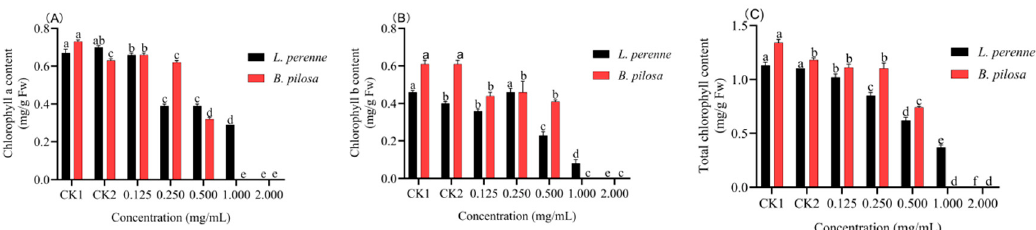
Figure 2. Effect of different concentration of L. pungens essential oil on photosynthetic pigments content (CK1, blank control; CK2, negative control; ( A ), Chlorophyll a content; ( B ), Chlorophyll b content; ( C ), Total chlorophyll content). Note: different lowercase letters (a–f) represent statistical differences (Tukey’s test p <